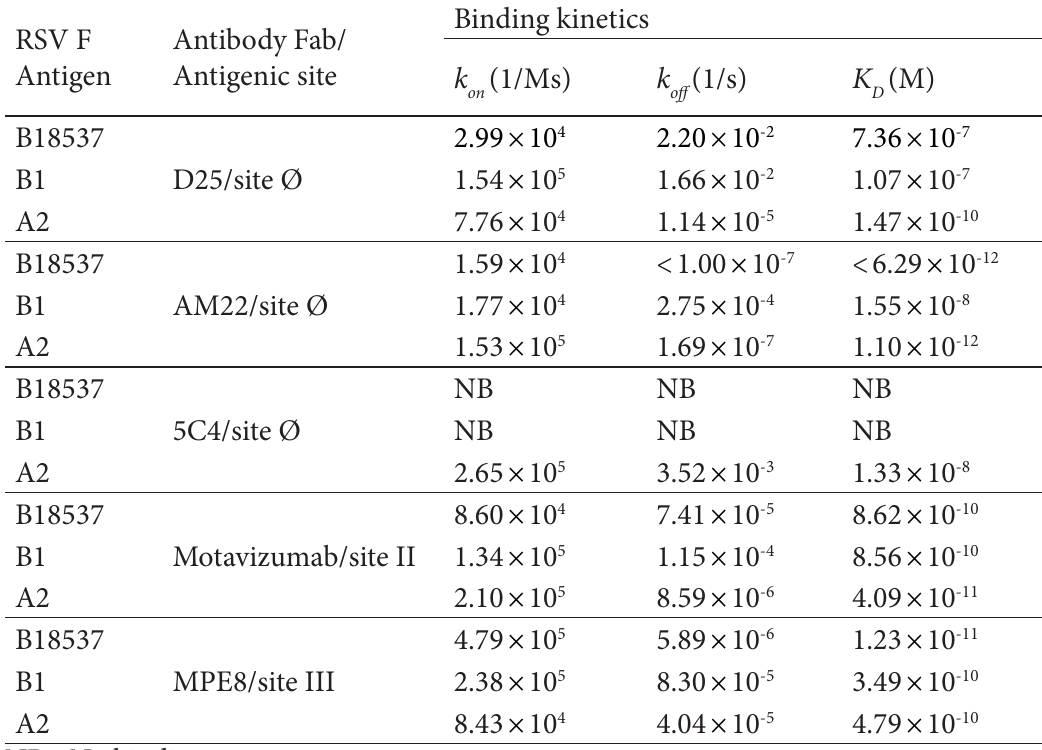
Table 1. Antigenic characterization of RSV DS-Cav1 F